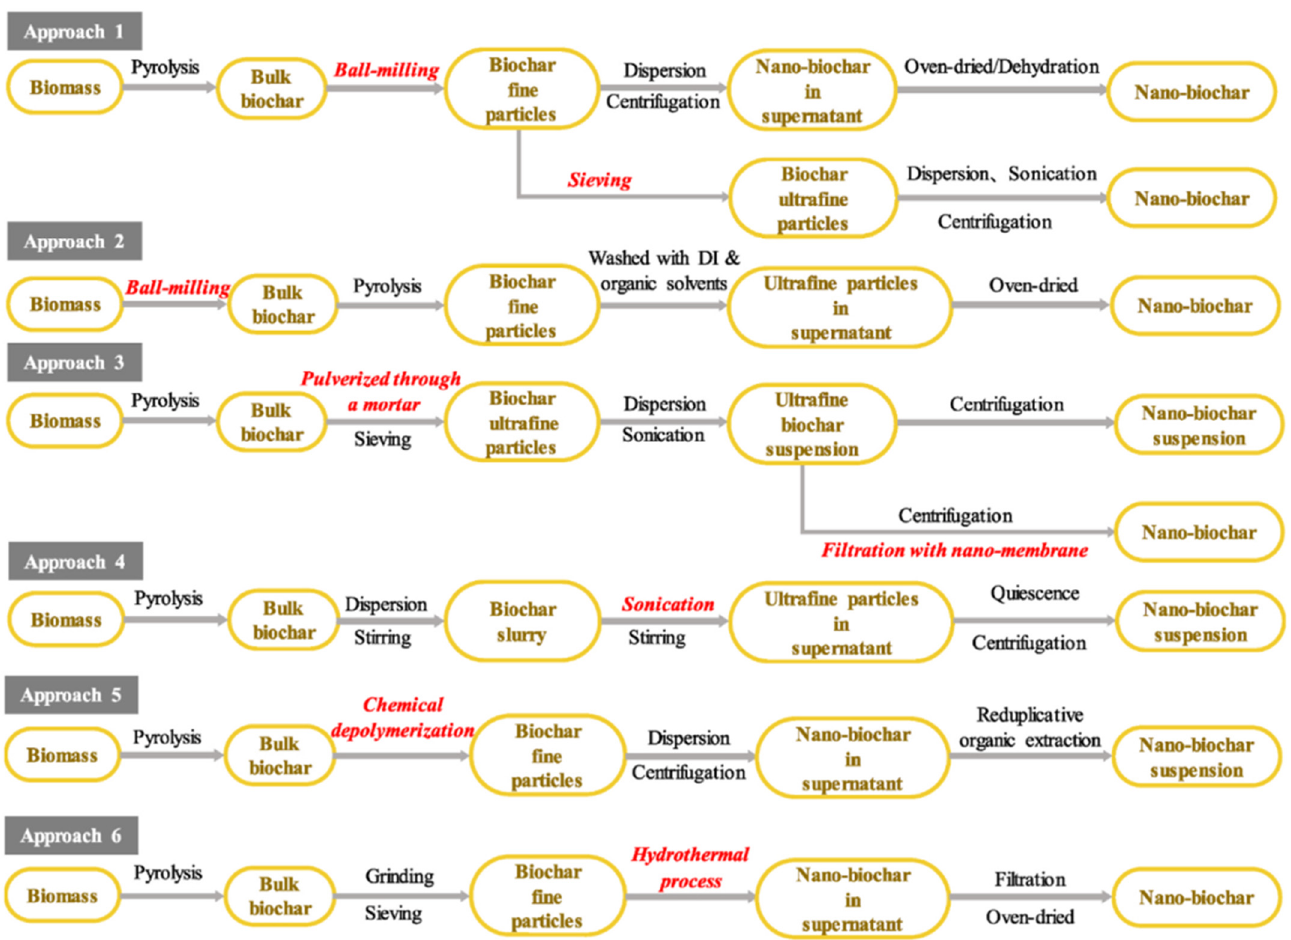
Figure 11. Commonly employed preparation routes for nano-biochar from biomass feedstock [159]. In comparison with bulk BC that is normally measured on a micron or millimetre scale, nano-biochar is defined as biochar with a particle size of <100 nm. However, a wide range of particle sizes has been considered as nano-biochar in the literature, with particle sizes from 0 to 600 nm being considered as nano-biochar. The particle size of nano-BC is highly dependent on the various feedstocks and preparation methods. For the same feed- stock, increasing the pyrolysis temperature can lead to a decrease in particle sizes. For instance, increasing the pyrolysis temperature for rice straw from 400 to 700 °C caused a decrease in particle size from 403 to 234 nm using the centrifuging separation method, as reported by Lian et al. [160]. Likewise, when using the same nano-BC preparation route, increasing the pyrolysis temperature from 300 to 600°C for rice hull feedstock yielded particles with sizes ranging between 190 and 59 nm.